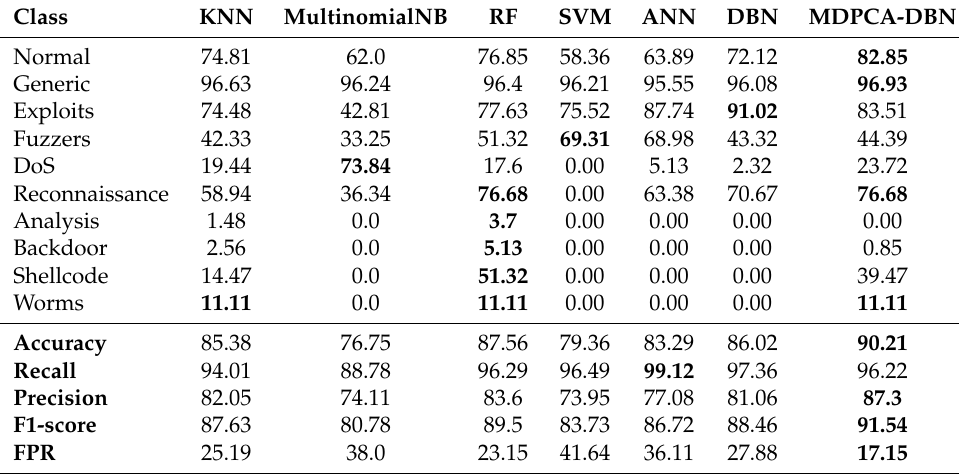
Table 12. Comparison results for the UNSW-NB15 dataset